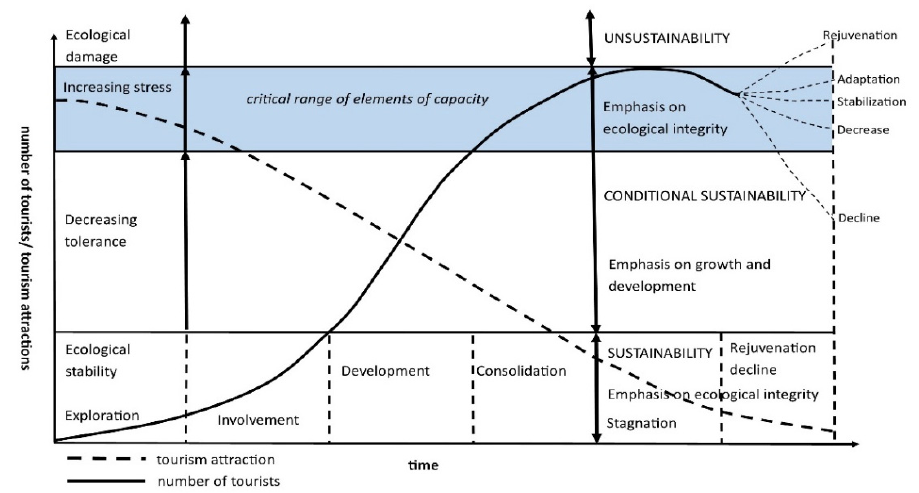
Figure 3. Life cycle model of a recreation center concerning sustainable development. Source [33,42].